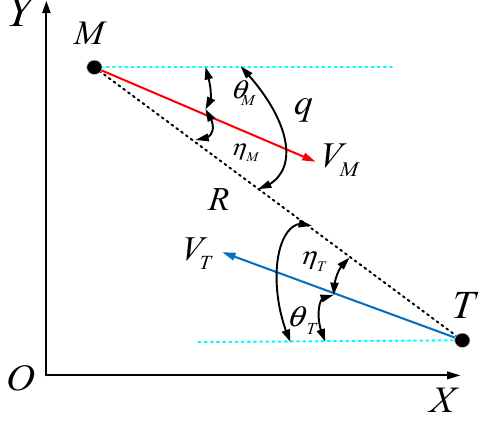
Figure 4. Diagram of missile-target motion relationship.